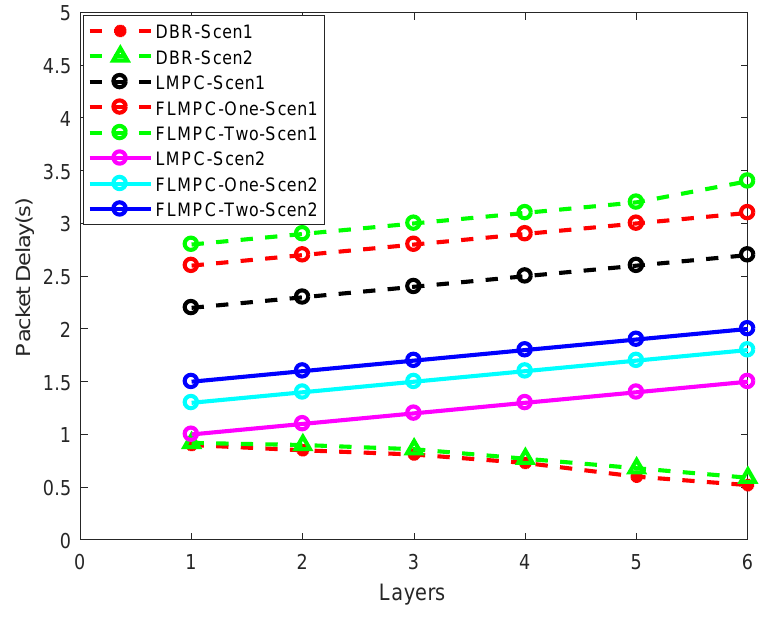
Figure 10. End-to-end